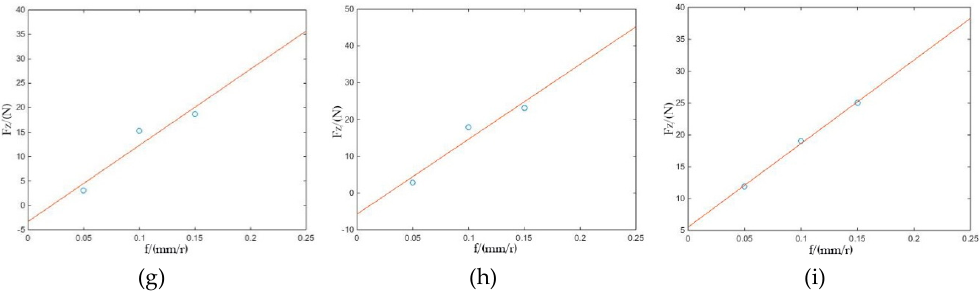
Figure 5. Linear parameter calibration. ( a ) The k a was calibrated at the cutting speed of 150 m/min; ( b ) The k a was calibrated at the cutting speed of 200 m/min; ( c ) The k a was calibrated at the cutting speed of 250 m/min; ( d ) The k r was calibrated at the cutting speed of 150 m/min; ( e ) The k r was calibrated at the cutting speed of 200 m/min; ( f ) The k r was calibrated at the cutting speed of 250 m/min; ( g ) The k t was calibrated at the cutting speed of 150 m/min; ( h ) The k t was calibrated at the cutting speed of 200 m/min; ( i ) The k t was calibrated at the cutting speed of 250 m/min. To verify the difference, Figure 6 illustrates a two-dimensional parameter variation of the single- factor experiment, using TiAlN coated tools. The results showed that the force parameters of TiAlN coated tools, under different cutting speed, have a turning point, which indicates that the force on the cutting edges gradually changes as the cutting speed increases. It can be noted that the cutting speed at 200 m/min could be an important factor in implying a variation of the milling process.